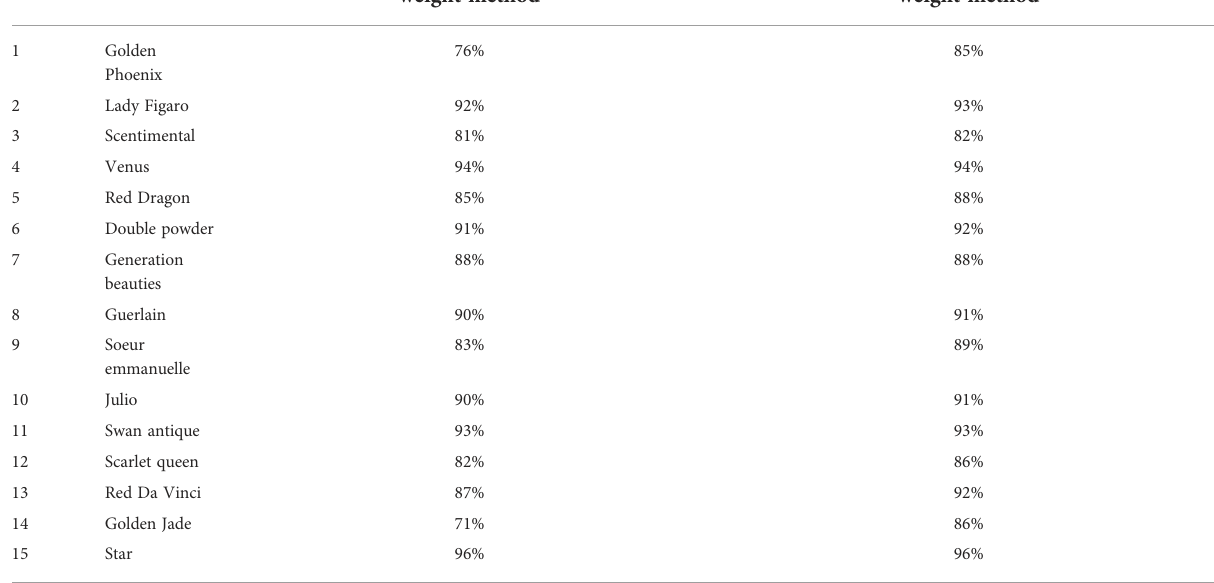
TABLE 4 Classi fi cation accuracy of 3D Chinese rose